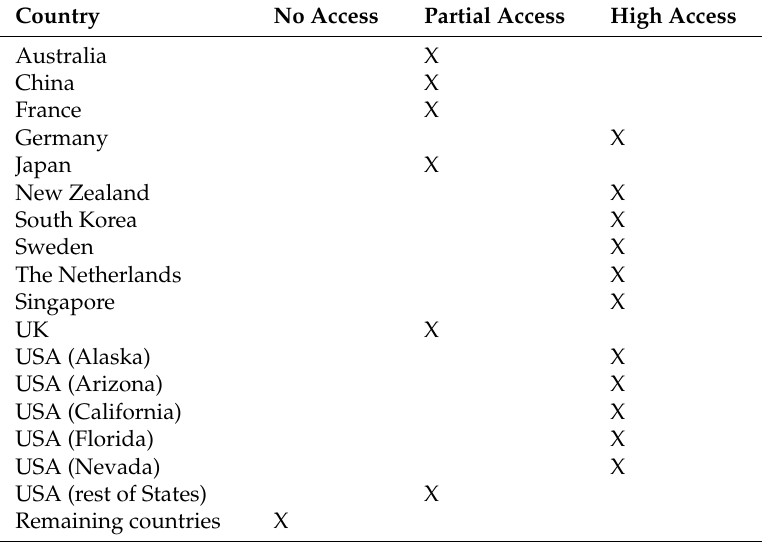
Table 9. Permitted access to public roads for